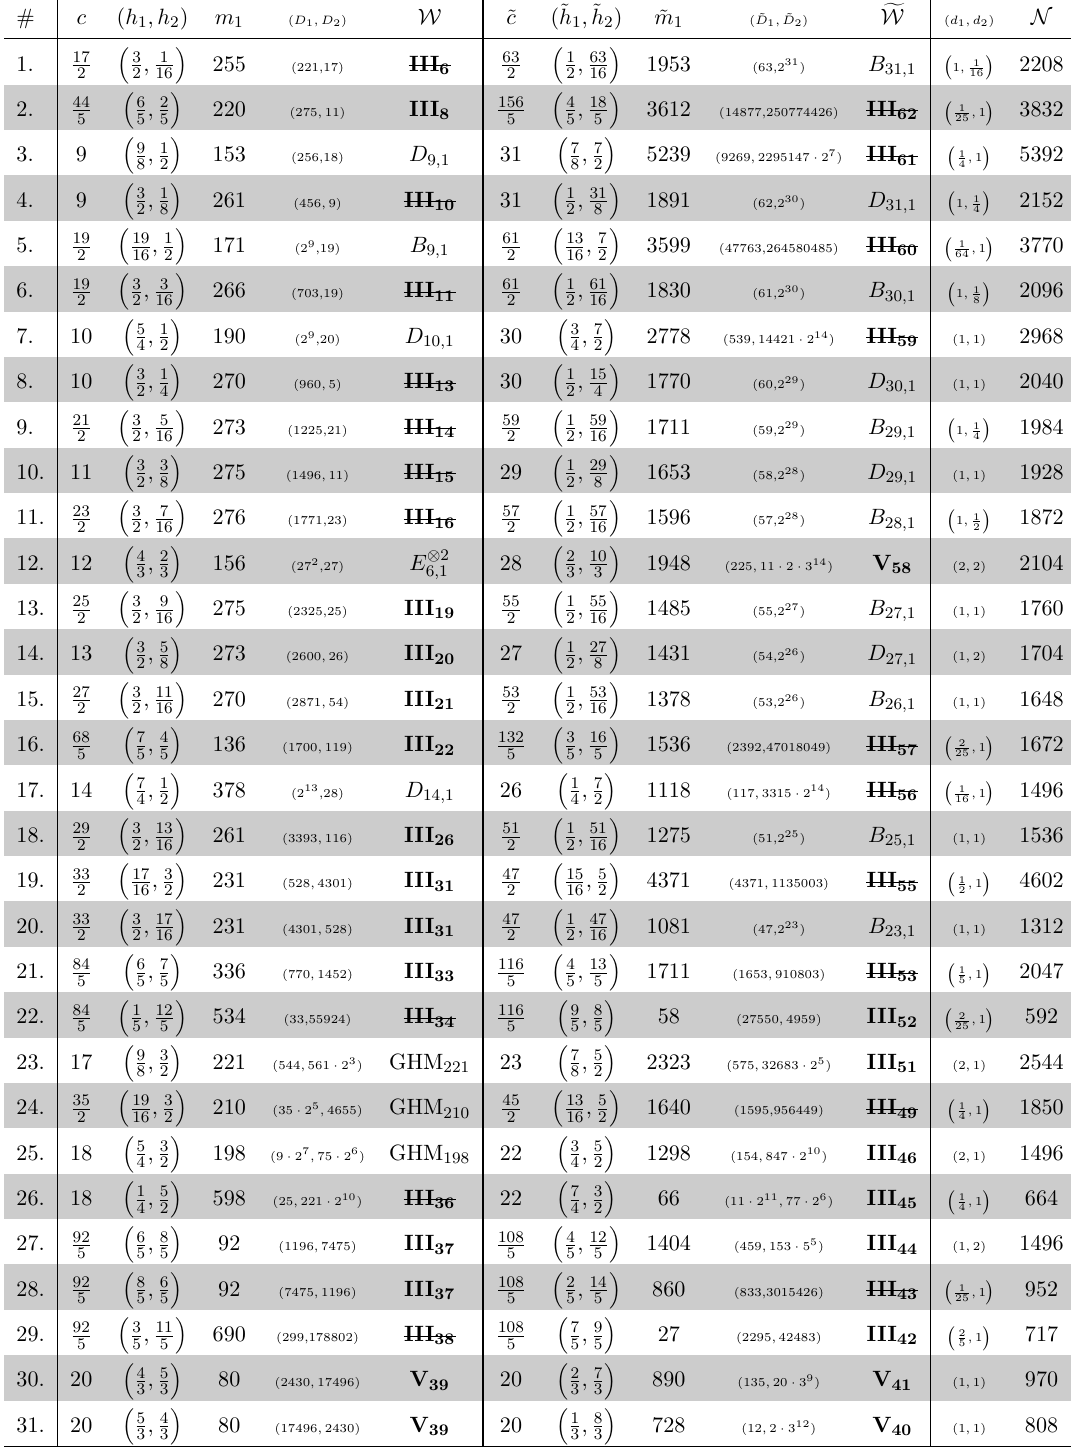
Table 21. Inconsistent pairings, c H = 40 with ( n 1 , n 2 ) = (2 , 4) . The meromorphic character is j 2 3 ( j − 1240 + N ) with N given in the last column of the